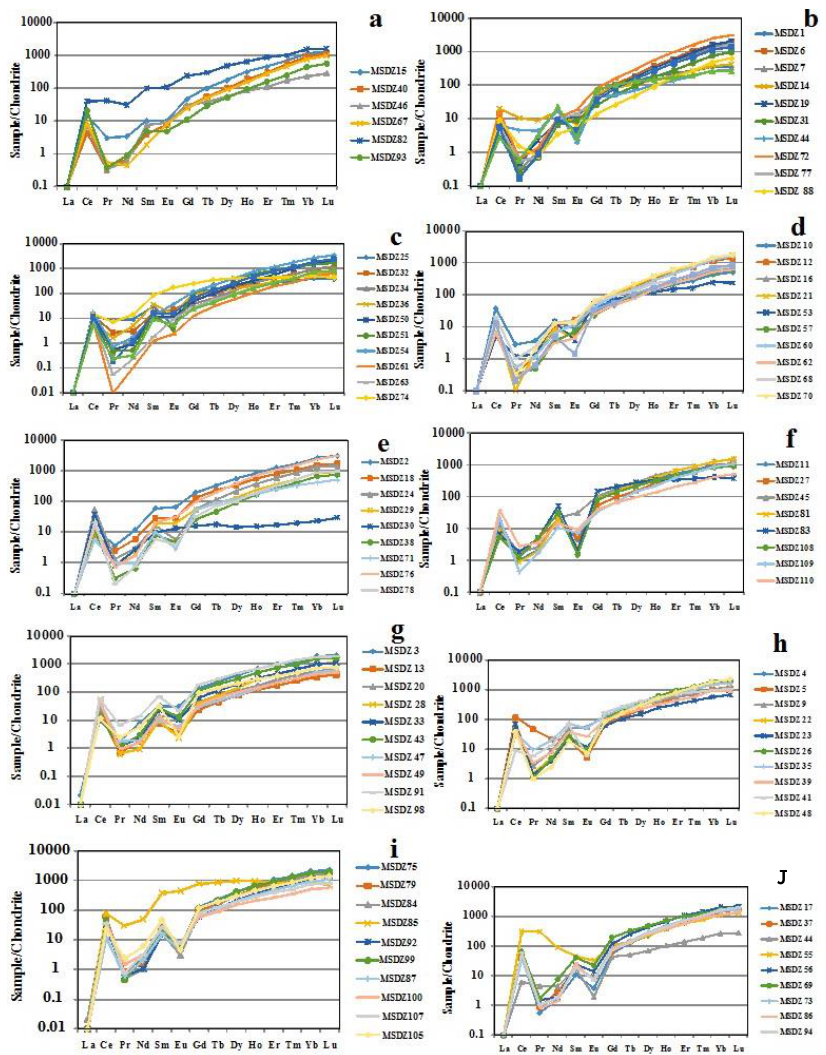
Figure 5. REE patterns for southern Meiganga zircons normalized to [69], chondrite values versus element (La–Lu) diagrams (( a ) zircon with Th/U < 0.2; ( b – d ) zircon with Th/U [0.2 to 0.5]; ( e – g ) zircon with Th/U [>0.5 to 1.0]; ( h – j ) zircon with Th/U > 1.0).